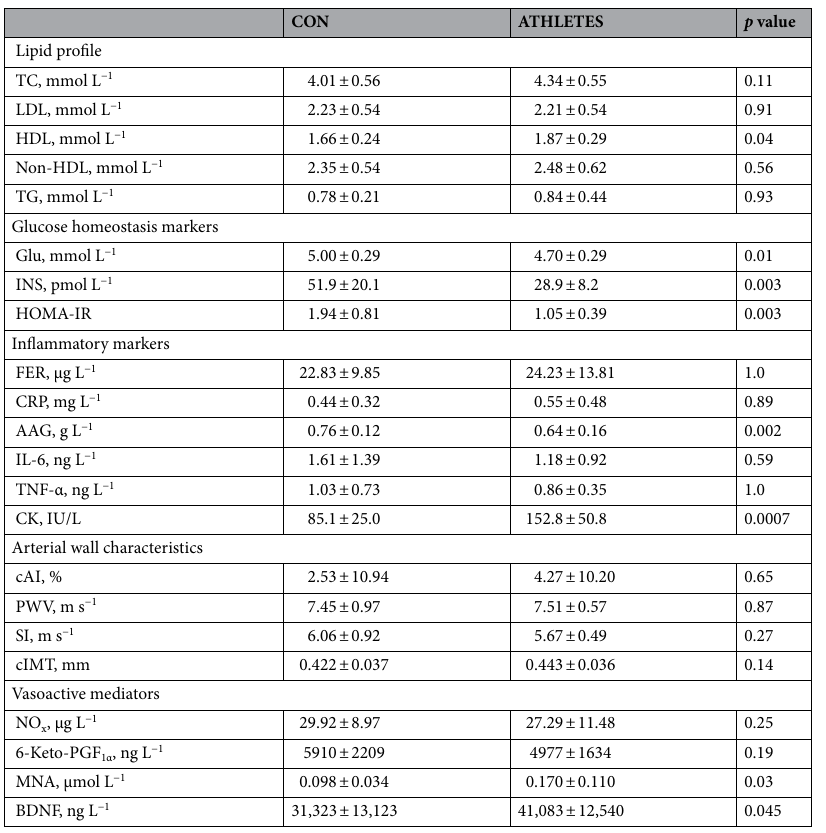
Table 2. Basal blood lipid profile, glucose homeostasis markers, inflammatory markers and arterial vasoactive mediators as well as arterial wall characteristics in controls (CON, n = 15) vs female athletes (ATH, n = 15). Data are given as mean ± SD. TC total cholesterol, LDL low density lipoprotein, HDL high density lipoprotein, non‑HDL non-high density lipoprotein, TG triglycerides, Glu glucose, INS insulin, HOMA‑IR homeostatic model assessment, FER ferritin, CRP c-reactive protein, AAG alpha-1-acid glycoprotein, IL‑6 interleukin-6, TNF‑α tumor necrosis factor-alpha, CK total creatine kinase, cAI central augmentation index, PWV pulse wave velocity, SI stiffness index, cIMT carotid intima-media thickness, NO x the sum of nitrate and nitrite, 6‑keto‑